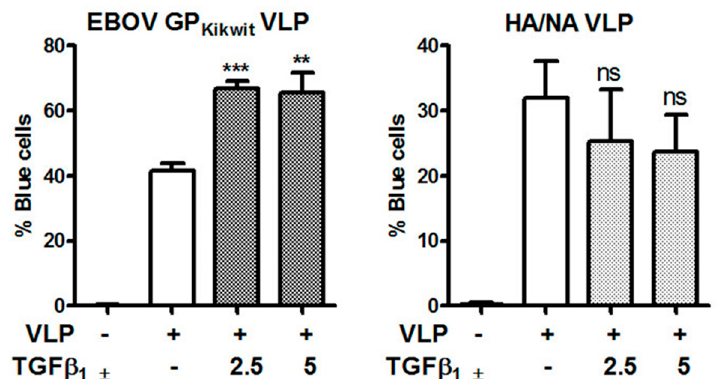
Figure 7. TGF- β 1 enhances fusion of primary MDM with VLPs pseudotyped with EBOV Kikwit GP. MDM were pre-incubated for 72 h in macrophage medium supplemented with TGF- β 1 (2.5 or 5 ng/mL) or cytokine resuspension buffer (0.5% HSA DPBS) prior to infection with EBOV Kikwit VLP or HA/NA VLP, respectively. The cells were processed and the VLP entry/fusion was analyzed by Laser Scanning Cytometry, as described in Materials and Methods. No significant difference was observed in the background fluorescence of uninfected TGF- β 1 or mock treated cells. ** p ≤ 0.01; *** p ≤ 0.001; ns = not significant.